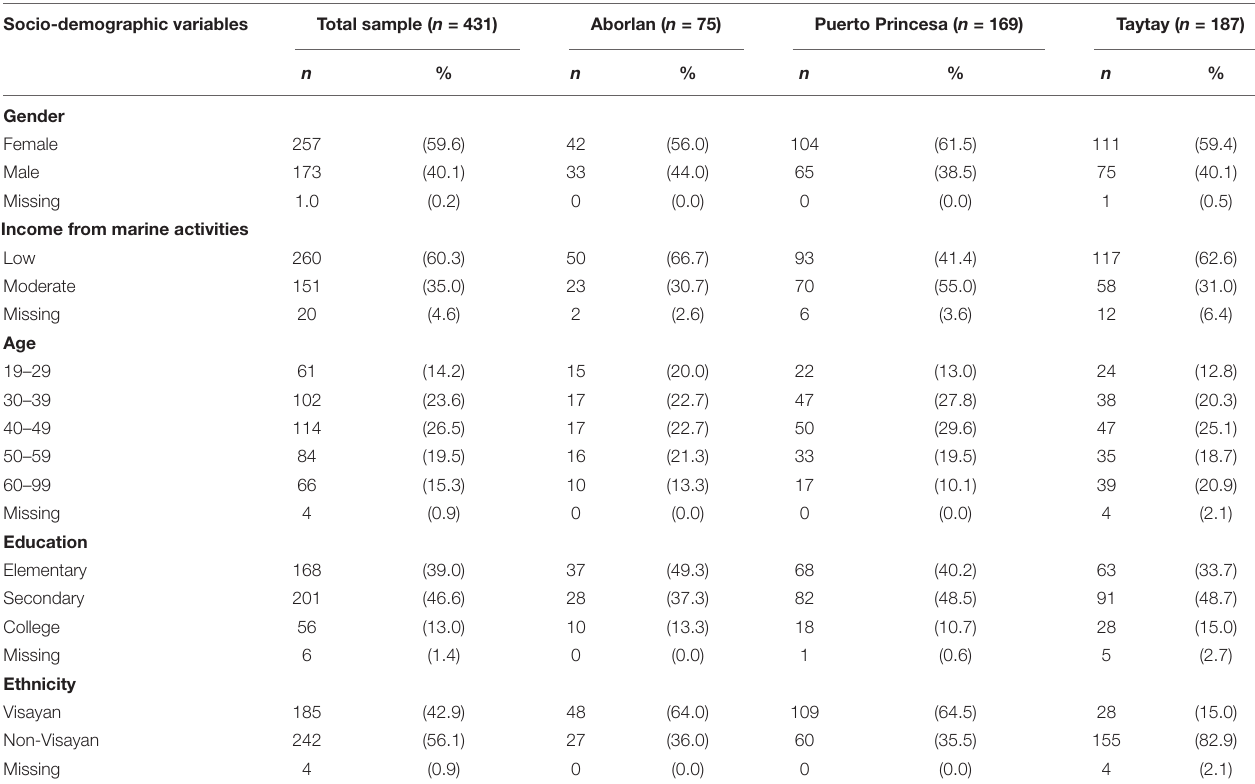
TABLE 1 | Socio-demographic profile of adult participants in Palawan, Philippines. Socio-demographic